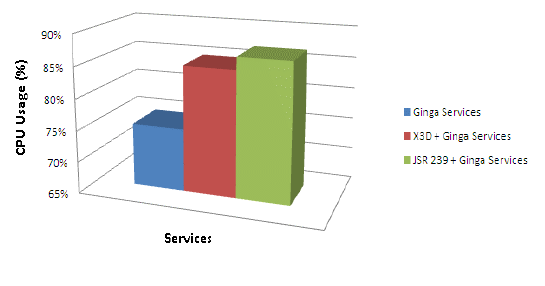
Figure 11. CPU usage for Ginga specific